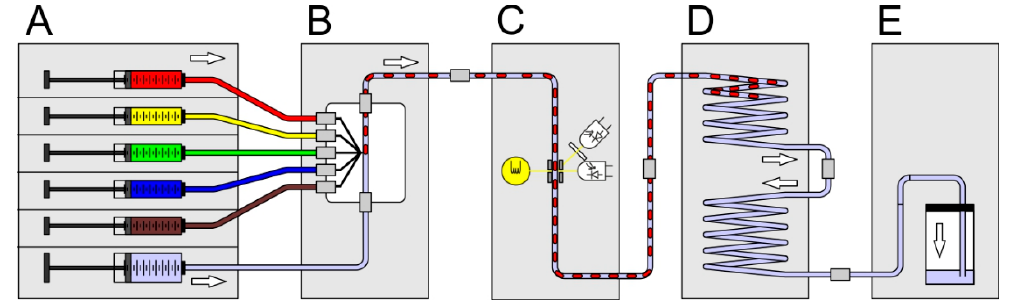
Figure 3. Schematic setup assembled for the generation of droplet sequences using a combination of different modules ( A – E ). Individual modules are connected by transparent FEP-tubes and standard fluidic connectors. ( A ) Syringe pump with six channels for fluid actuation (www.cetoni.de); ( B ) droplet generator; ( C ) photo-fluorimetric sensor module to record the initial photo-fluorimetric reference signals; ( D ) droplet sequence storage and incubation coil; ( E ) void volume.